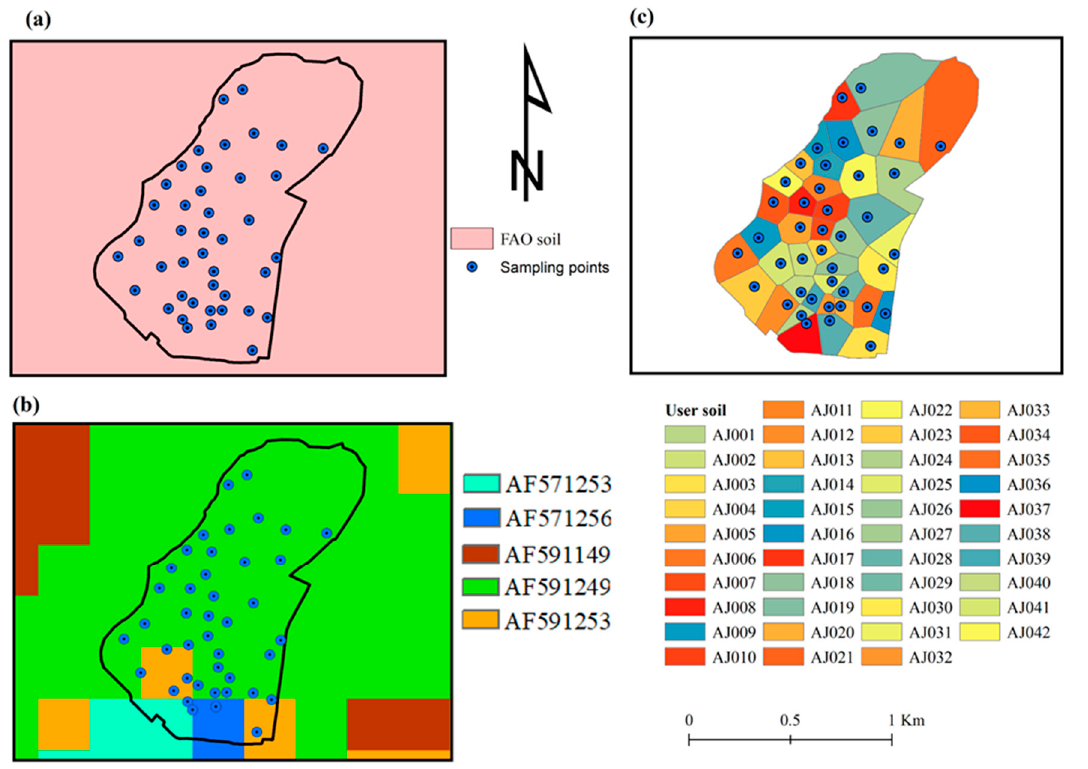
Figure 2. Maps of different soil data sources: ( a ) Food and Agriculture Organization (FAO) soil dataset, ( b ) Africa Soil Information Service (AfSIS) soil database, and ( c ) user soil developed based on 42 filed sampling points.